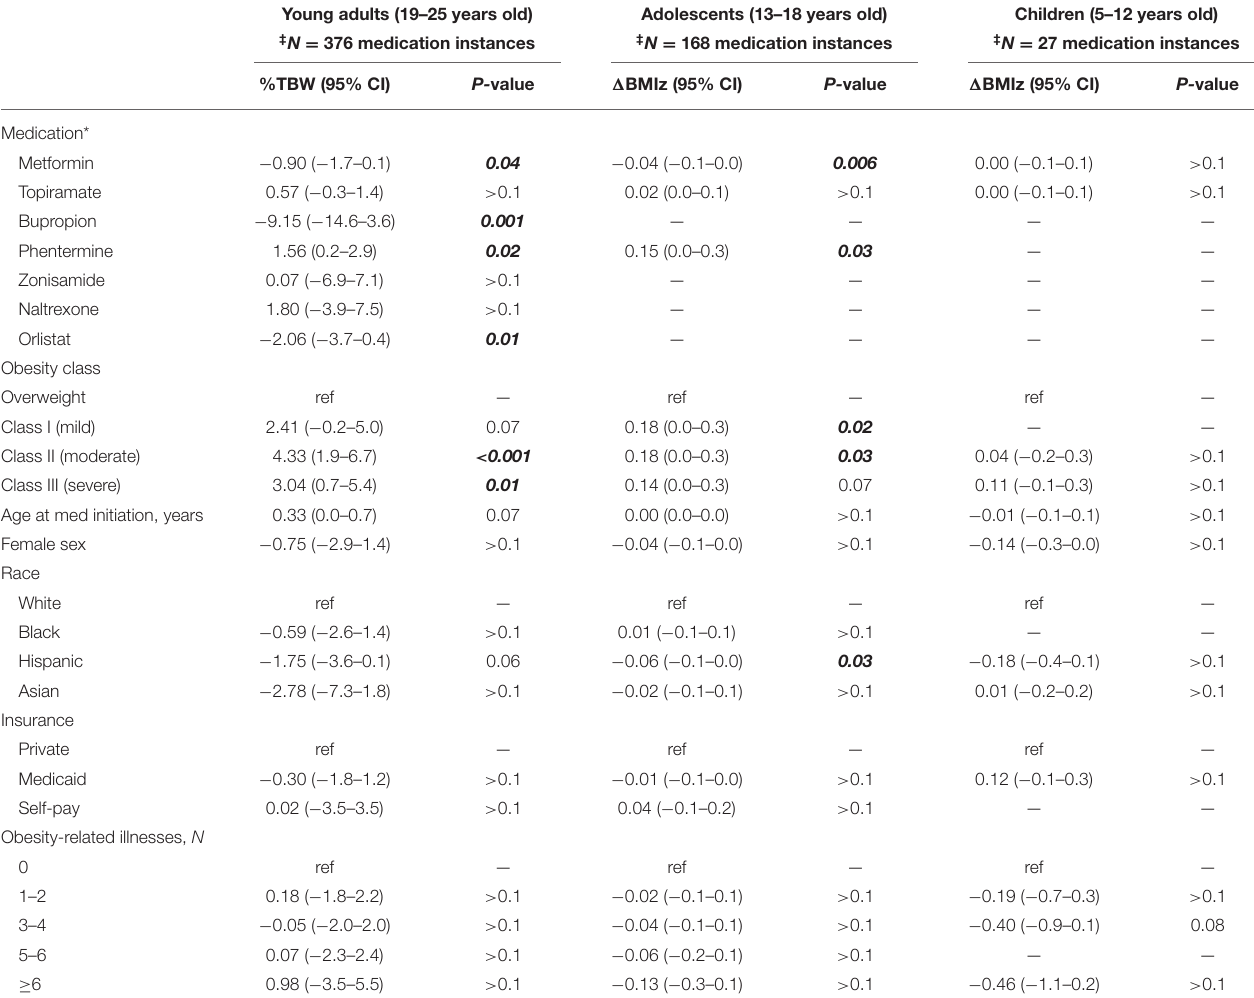
TABLE 9 | Effect on maximum weight loss, off-label patients—adjusted